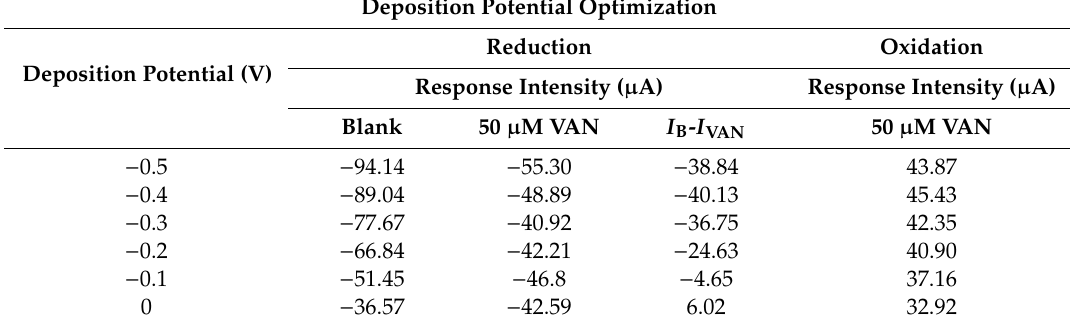
Table 1. Optimization of the electrogeneration procedure.